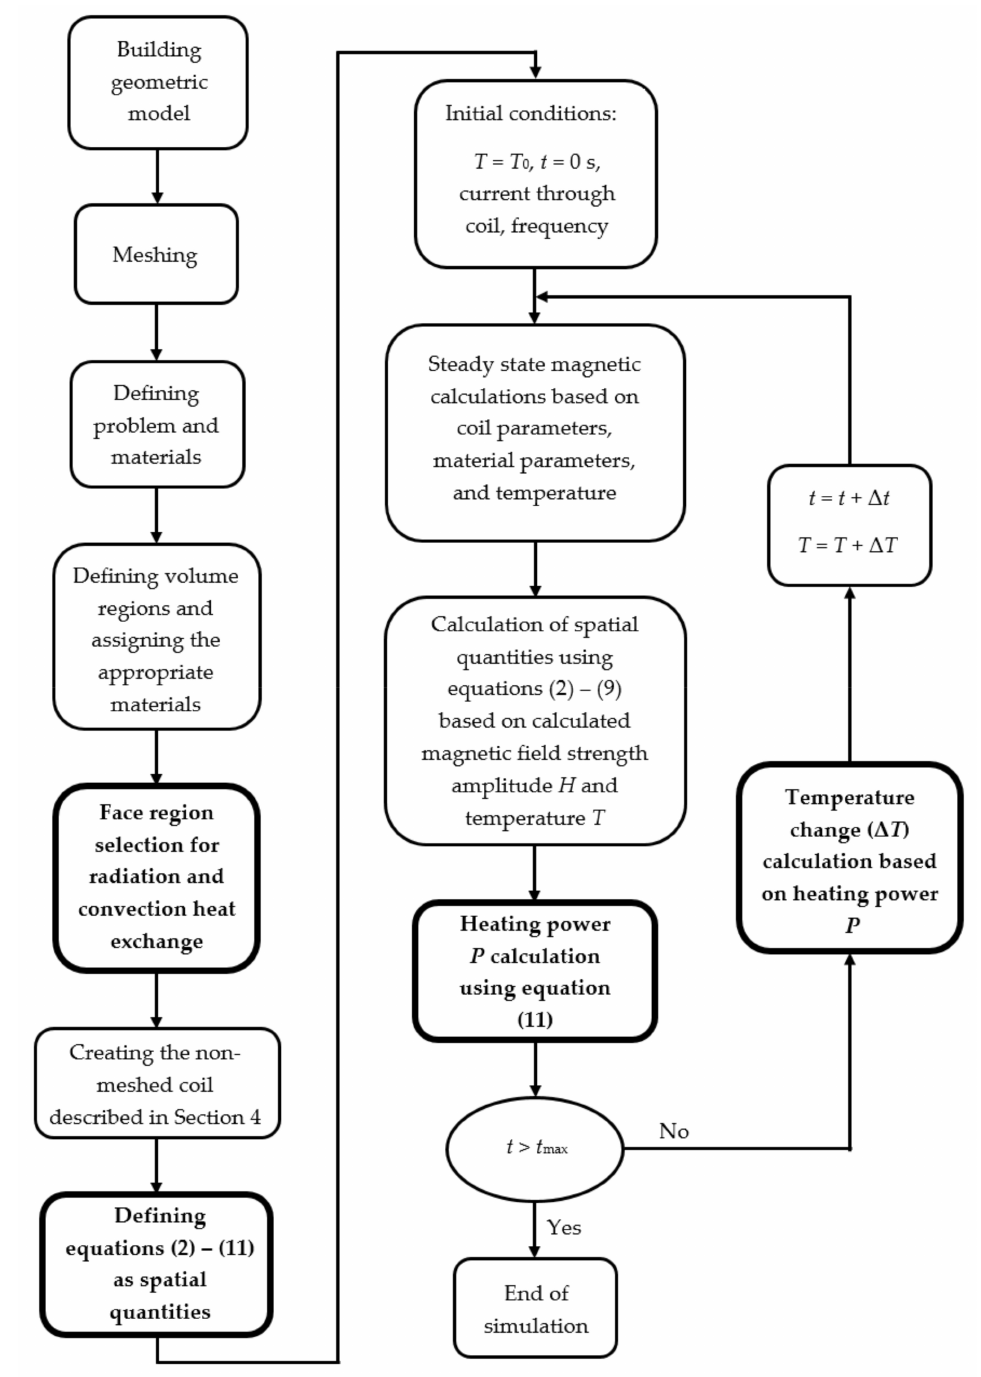
Figure 4. Simulation flowchart. After the simulation ended, the average magnetic field strength amplitude in the whole magnetic fluid volume was calculated for each time step and the average value over time was taken. To get the temperature and SAR values, one point inside the magnetic fluid (the position of a temperature measuring sensor used in the case of measurement) was chosen to simulate the temperature measurement with a temperature probe. The location of the reading is shown in Figure 5, together with the Infinite box boundary